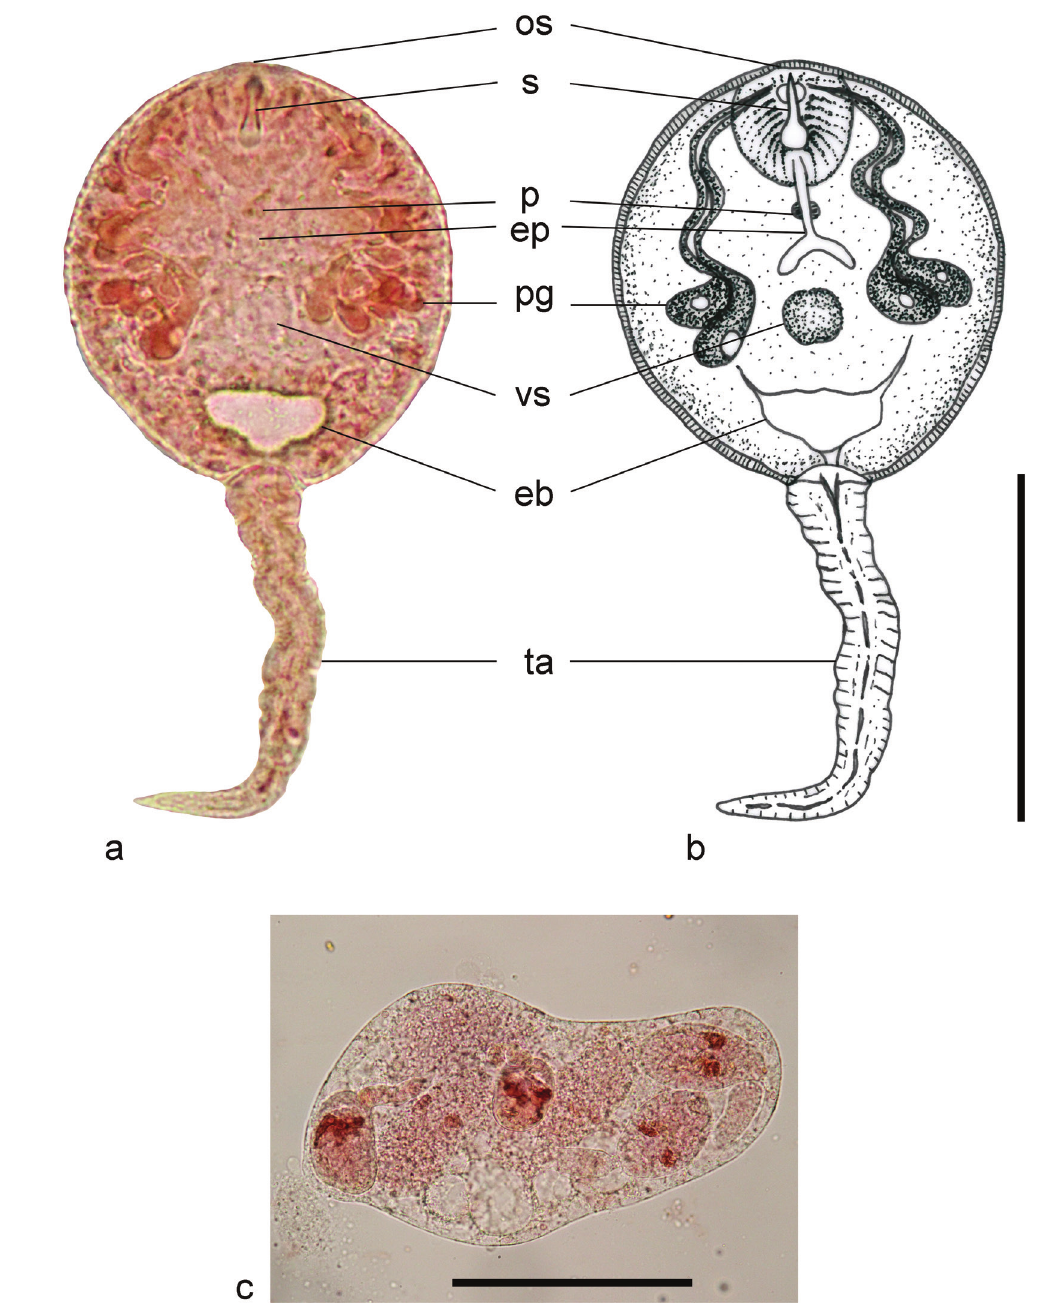
Figure 6. Maritreminoides caridinae (Yamaguti & Nisimura, 1944). a . specimen stained with 0.5% neutral red. b . drawing of cer- caria. c . sporocyst stained with 0.5% neutral red. Abbreviations – eb: excretory bladder; ep: esophagus; os: oral sucker; p: pharynx; pg: penetration gland; s: stylet; ta: tail; vs: ventral sucker. Scale bars: 50